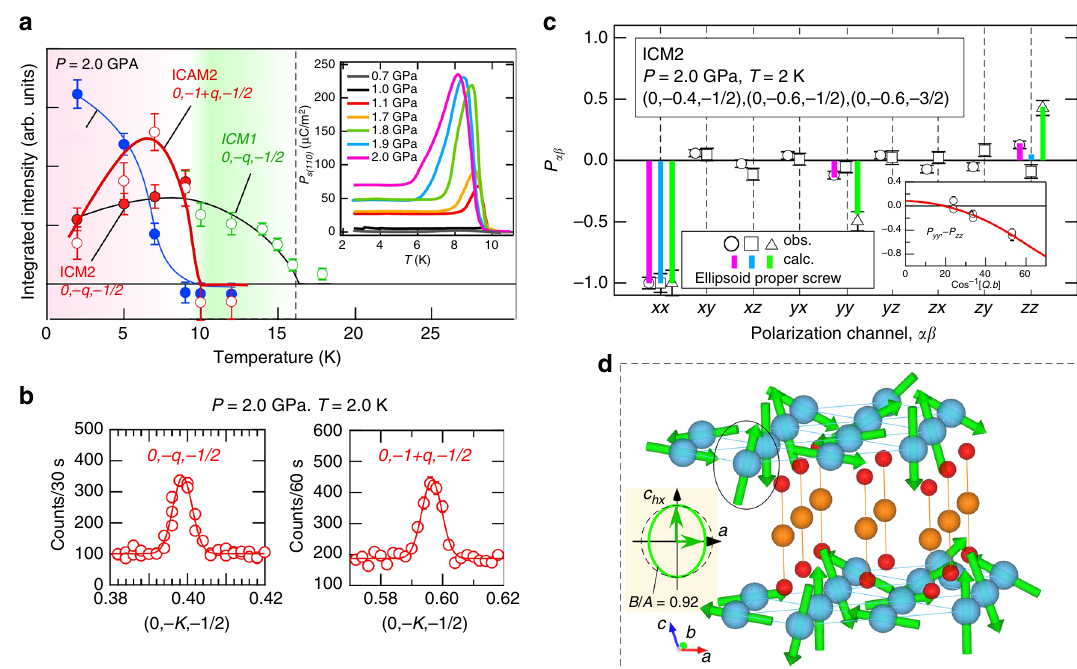
Fig. 3 Spherical neutron polarimetry data at 2.0 GPa. a Temperature dependence of the integrated intensities of magnetic re fl ections and b typical diffraction pro fi les along the [0, − K , − 1/2] line for the spin fl ip channel in the x -direction at P = 2.0 GPa. The inset in a shows the temperature dependence of electric polarization along the hexagonal [110]-direction (the monoclinic b -axis) in typical pressures up to 2.0 GPa under poling electric fi eld 286 kV/m. c A comparison between observed and calculated polarization matrix elements for 0, − 0.4, − 1/2 (red), 0, − 0.6, − 1/2 (light blue), and 0, − 0.6, − 3/2 (light green) re fl ections at T = 2 K and P = 2.0 GPa. The inset in c shows the fi tting results for the re fi nement of the ellipsoidal ratio | B |/| A | and the tilting angle θ . d An illustration of the magnetic structure determined under these conditions: an ellipsoidal proper screw structure with | B |/| A | = 0.92 ±